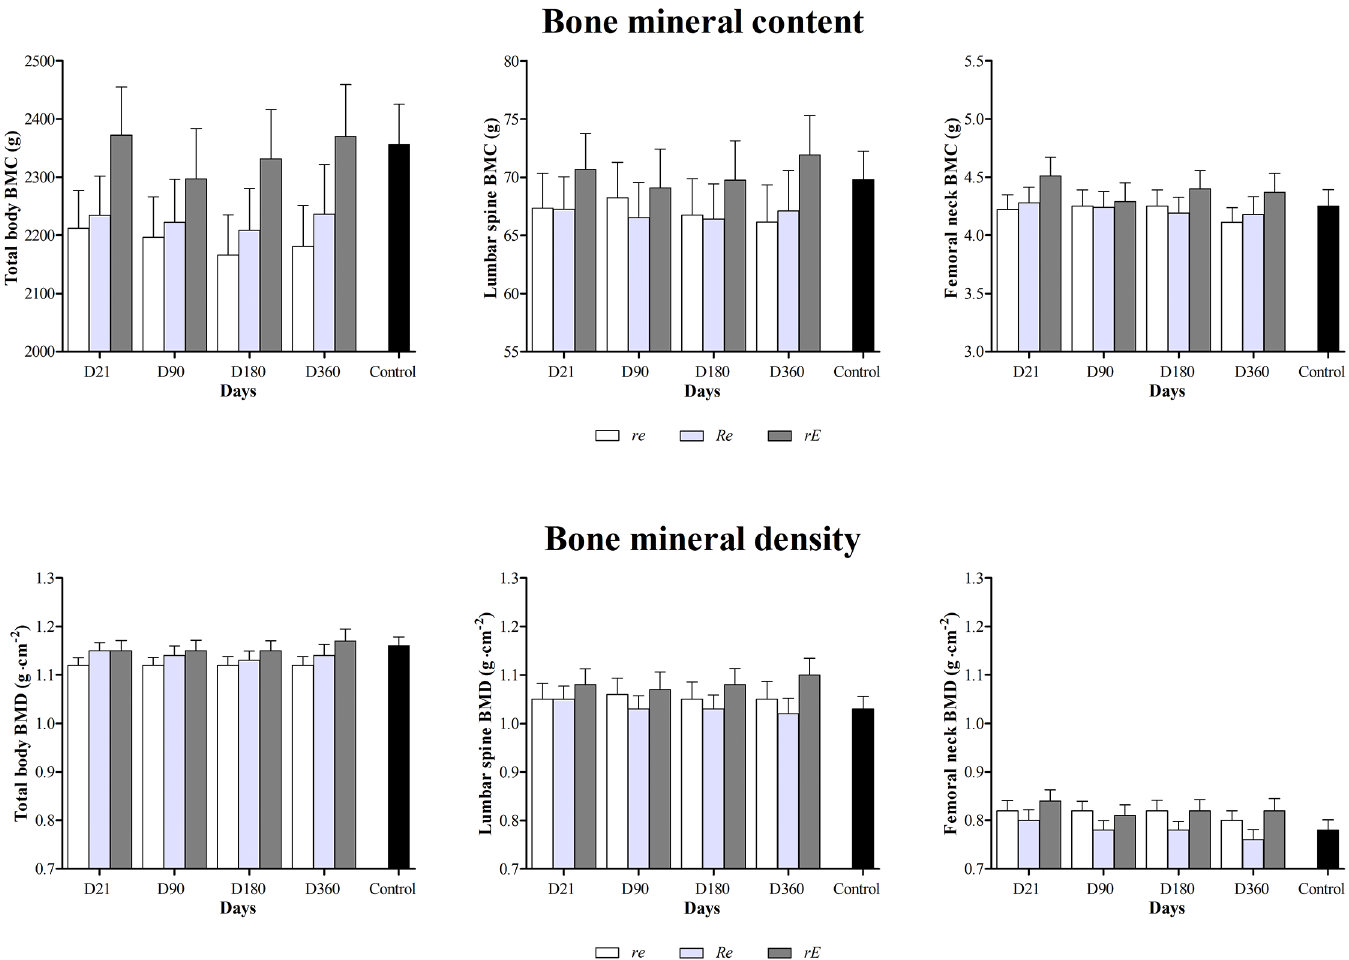
Fig 2. Changes (360 days) on total body bone mineral content (BMC) and density (BMD), lumbar spine BMC and BMD and femoral neck BMC and BMD for re , Re and rE groups. re : moderate-resistance-moderate-endurance; Re : high-Resistance-moderate-endurance; rE : moderate-resistance-high- Endurance. There were no significant differences in BMD and BMC parameters between re , Re and rE participants across the intervention. Participants in the intervention did not have significantly greater or lower bone mass or density development than controls.